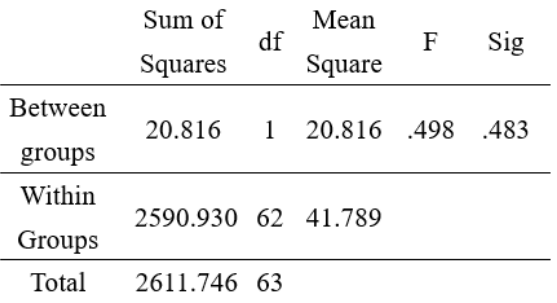
Table 3. One-way ANOVA test result of